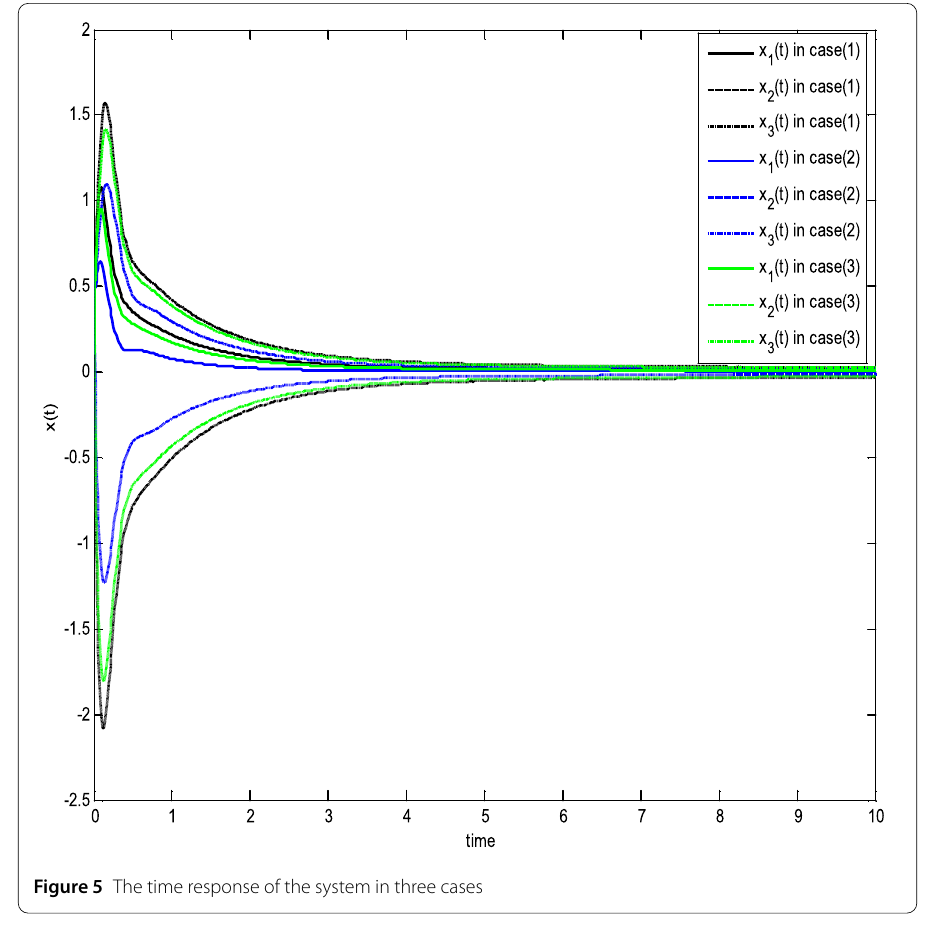
Figure 5 The time response of the system in three cases